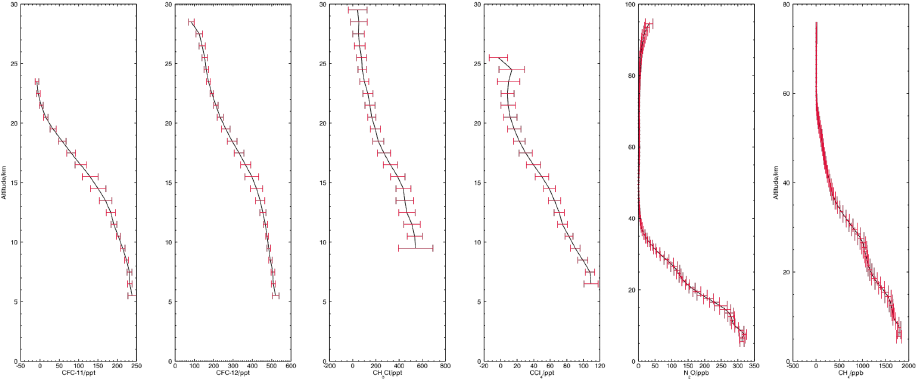
Figure C1 The mean vertical profile of CFC-11, CFC-12, CH3Cl, CH4 & N2O, calculated using data from 2009 between 90° and 75° North Fig. C2. The mean vertical profile of CFC-11, CFC-12, CH 3 Cl, CCl 4 , N 2 O and CH 4 , calculated using data from 2009 between 90 ◦ and 75 ◦ N.